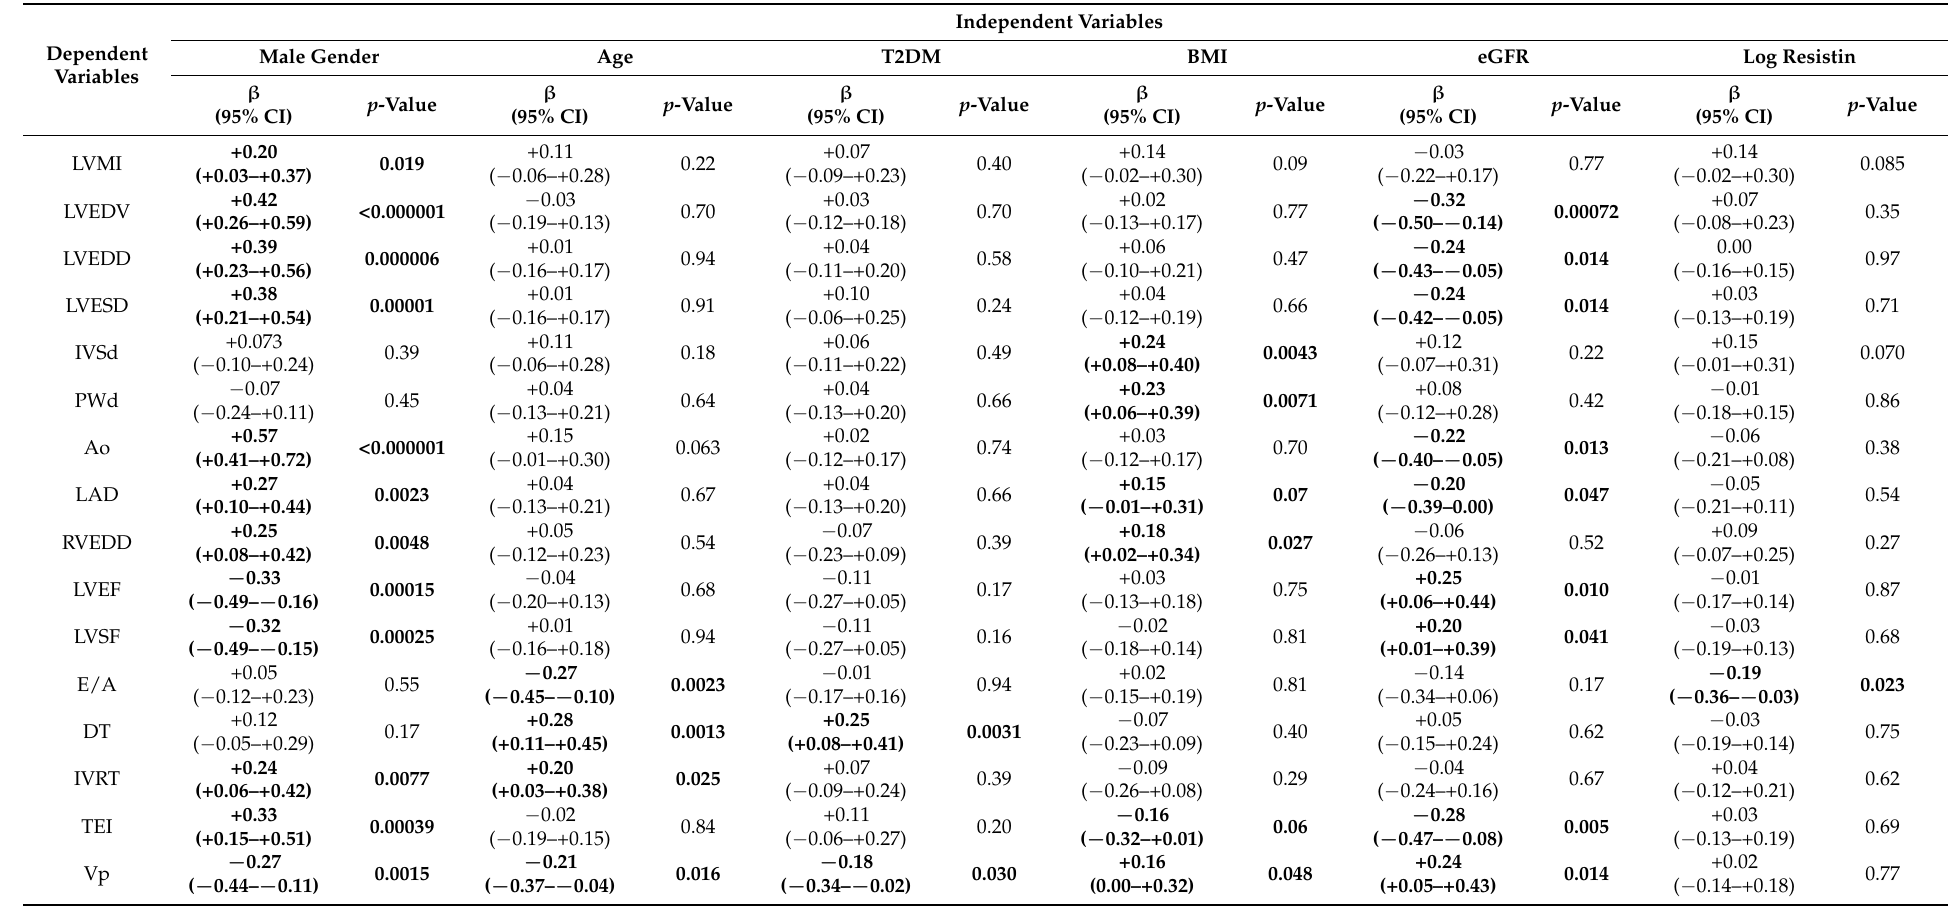
Table 5. Multivariate linear regression models for echocardiography parameters as dependent variables and male gender, age, T2DM, BMI, eGFR and logarithm of plasma resistin concentration as independent